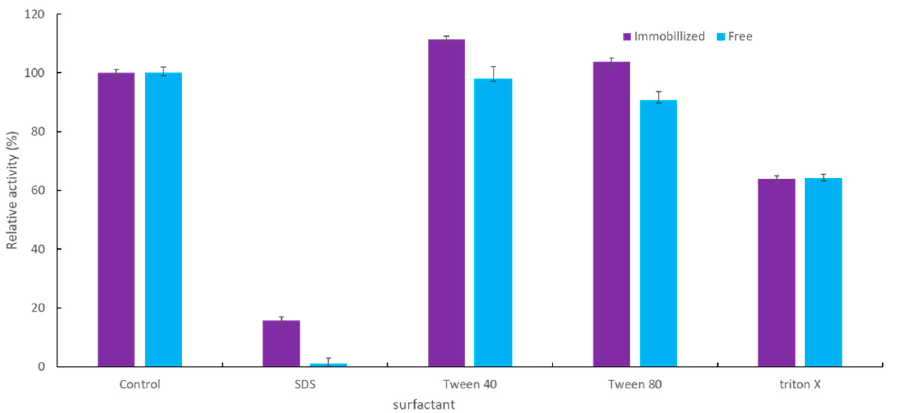
Figure 8. Effect of surfactant on activity of immobilized and free YT PTE. Purple columns: Relative activity of immobilized YT PTE; Blue columns: Relative activity of free enzyme.